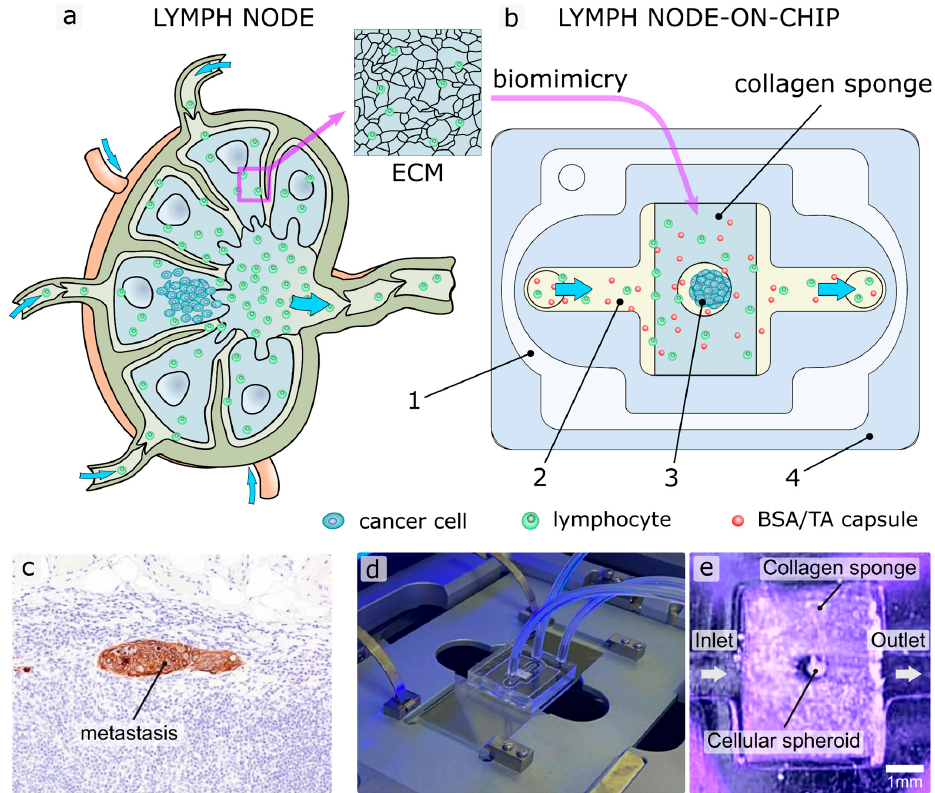
Figure 1. Engineering of LNOC. Schematic of the human native lymph node ( a ) and LNOC structure ( b ), reproducing structural features of LN with secondary tumor. 1—suction cup; 2—main channel; 3—cellular spheroid; 4—chip body. Cells stained in blue—secondary tumor cells, green—lymphocyte; red—capsules. ( c ) Secondary tumor due to metastasis in the sentinel lymph node (keratin stain). Reprinted with permission from Elizabeth Euscher (2020) [38]. ( d ) Photo of chip installed in